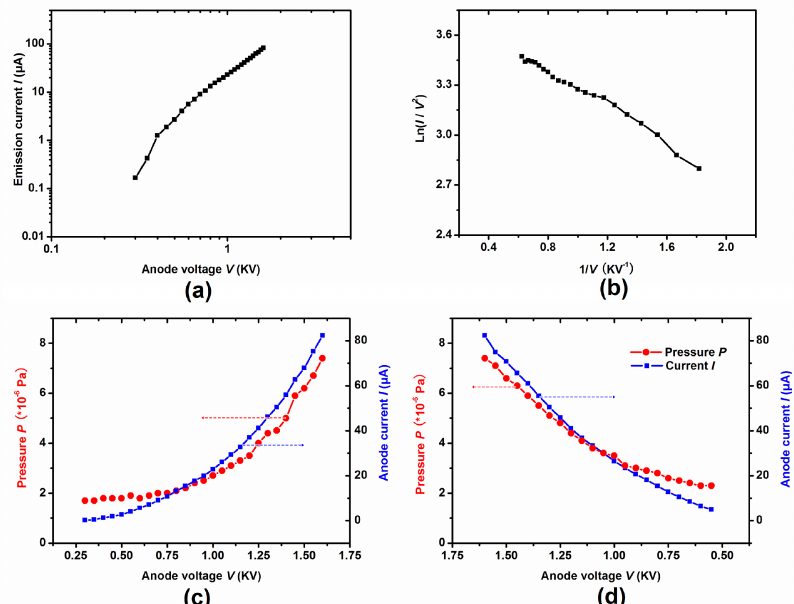
Figure 4. Field emission and emission stimulated desorption characteristics of ZnO nanomaterials. ( a ) Current–voltage plots of the field emission from ZnO nanomaterials. ( b ) The corresponding Fowler–Nordheim (FN) plots. ( c ) Pressure variation during field emission with anode voltage increasing. ( d ) Pressure variation during field emission with anode voltage